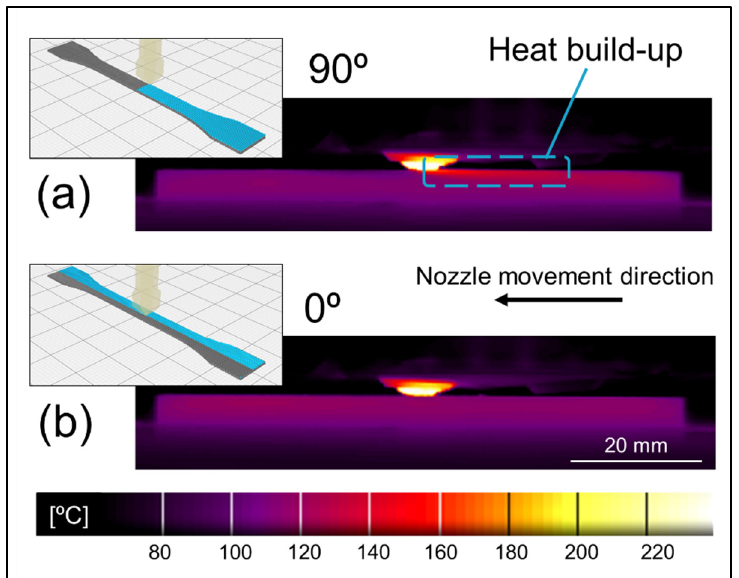
Figure 19. Infrared temperature measurement during printing of ( a ) 90° layers and ( b ) 0° layers. Blue lines represent completed roads from the current layer. Gray lines represent beads from the underlying layer.